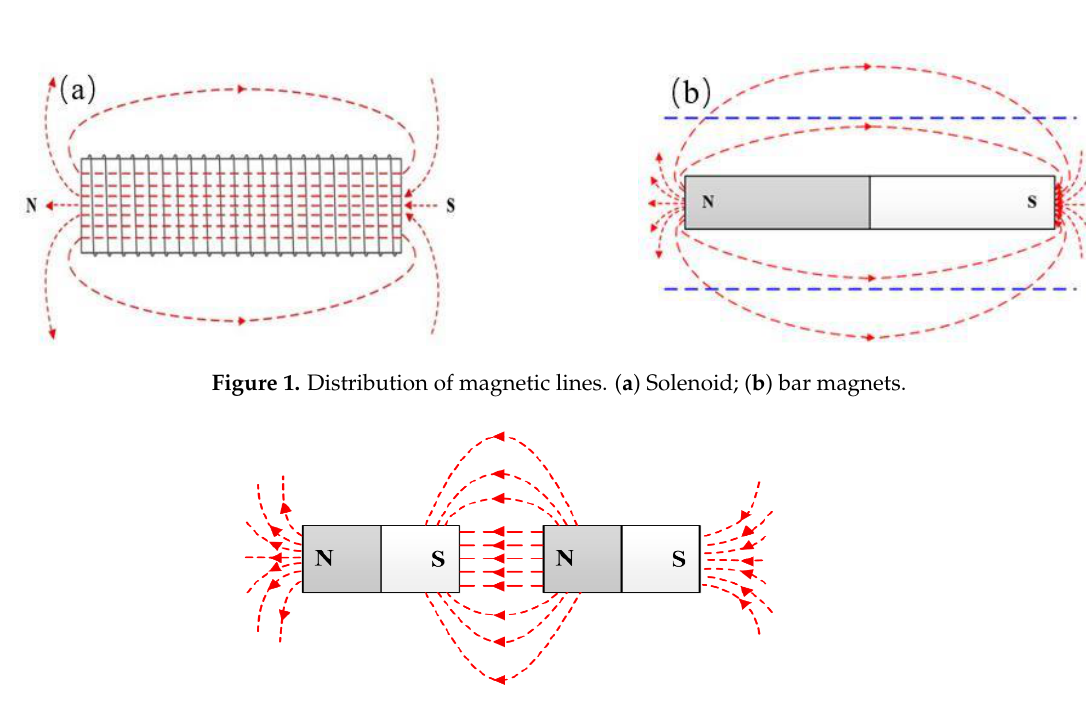
Figure 2. The distribution of magnetic lines when the different magnetic poles of two bar magnets approach each other.